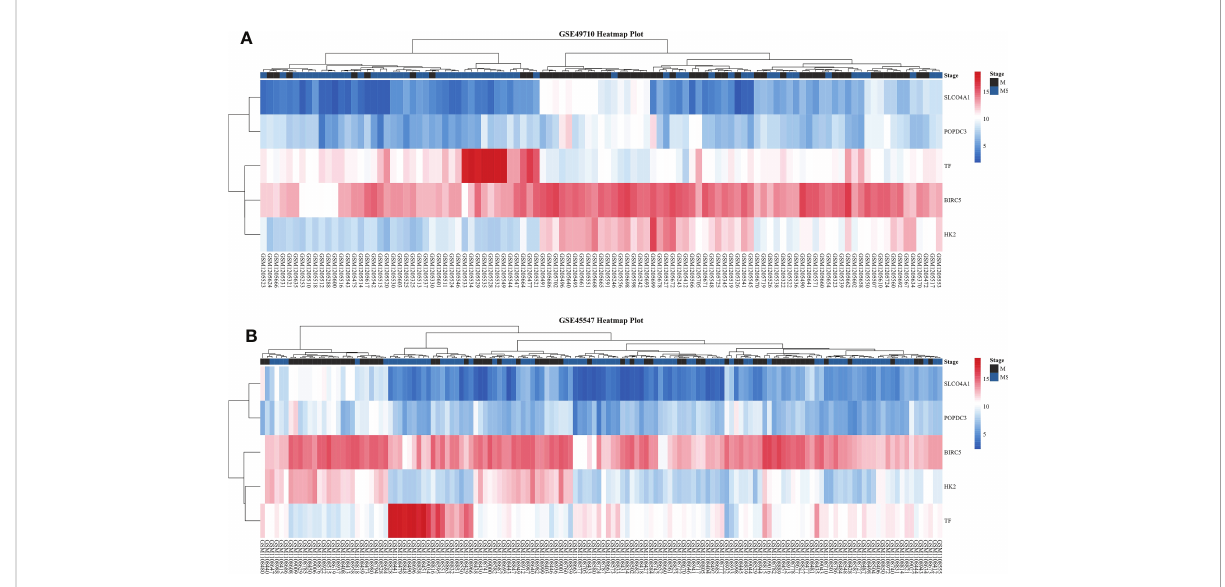
FIGURE 5 Heatmaps of fi ve DEGs in two datasets. (A) Heatmap of fi ve DEGs in GSE49710. (B) Heatmap of fi ve DEGs in GSE45547. From red to blue, the expression level of the DEGs in the sample gradually decreases.